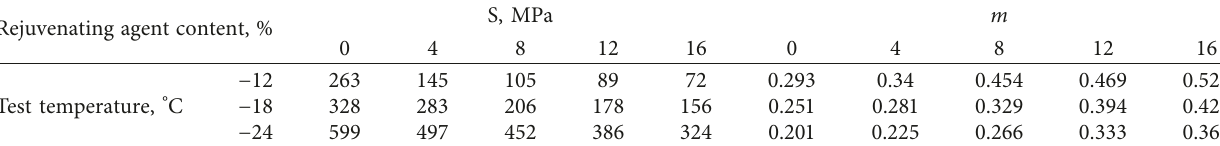
Table 12: Test results of BBR.